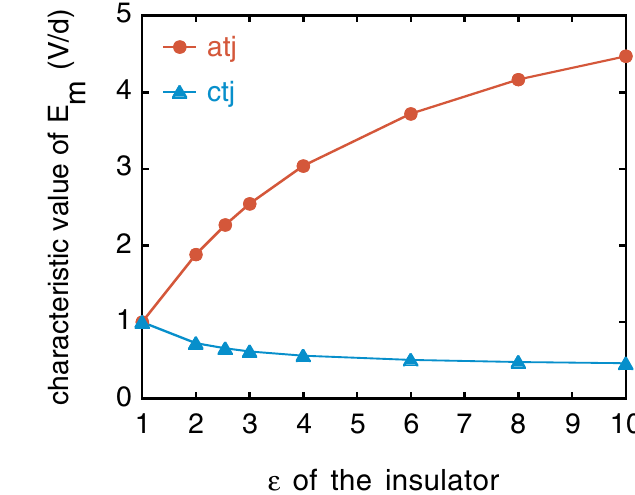
near the anode m